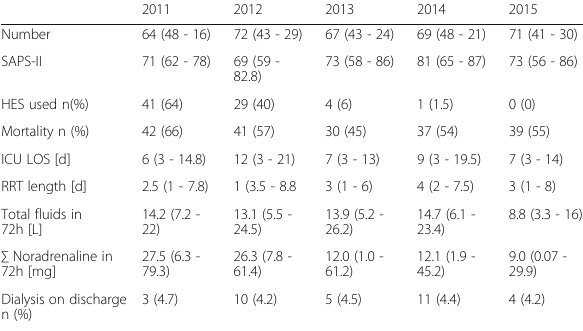
Table 104 (abstract A334). Patient characteristics per Year